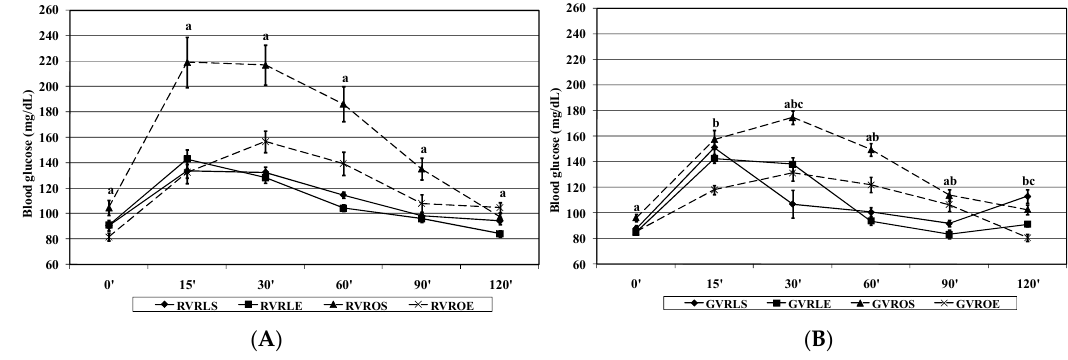
Figure 4. Effect of dietary treatment with raw or 4 day-germinated V. radiata and aerobic interval training protocol on blood glucose levels of lean and obese Zucker rats prior to or at different time points after oral glucose overload. ( A ) raw V. radiata (RVR), ( B ) 4 day-germinated V. radiata (GVR). Groups: LS, Lean ( fa /+) sedentary rats, LE, Lean ( fa /+) rats performing aerobic interval exercise, OS, Obese ( fa / fa ) sedentary rats, OE, Obese ( fa / fa ) rats performing aerobic interval exercise. Values are means ± SEM depicted by vertical bars ( n = 10). The following notation is used to express significant differences ( p < 0.05) between groups pointed out by Dunnet’s t -test: a, OS vs . LS, b, OE vs . LS, c, LE vs . LS.